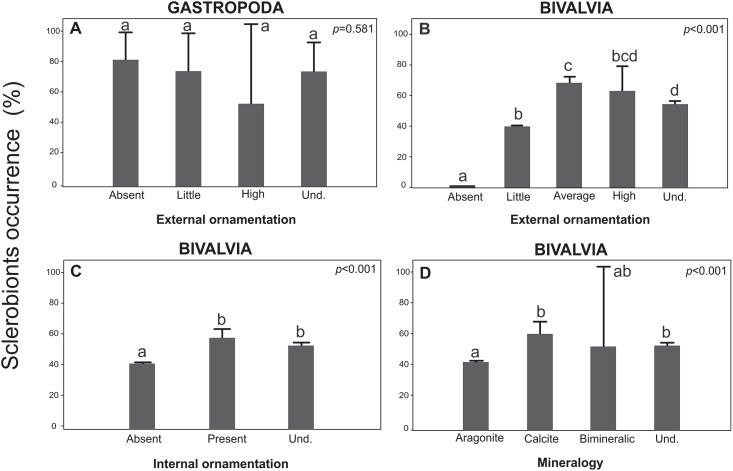
The occurrence of sclerobionts exposed to distinct ornamentation and mineralogy of the host substrates.(A) Gastropod external ornamentation. (B) Bivalvia external ornamentation. (C) Bivalvia internal ornamentation. (D) Bivalvia mineralogy. Und.: Unidentifiable. The vertical lines denote the 95% confidence intervals (standard error*1.96), and the lowercase letters indicate similarities (the same letters) or significant differences (different letters) between the factors (Tukey test).